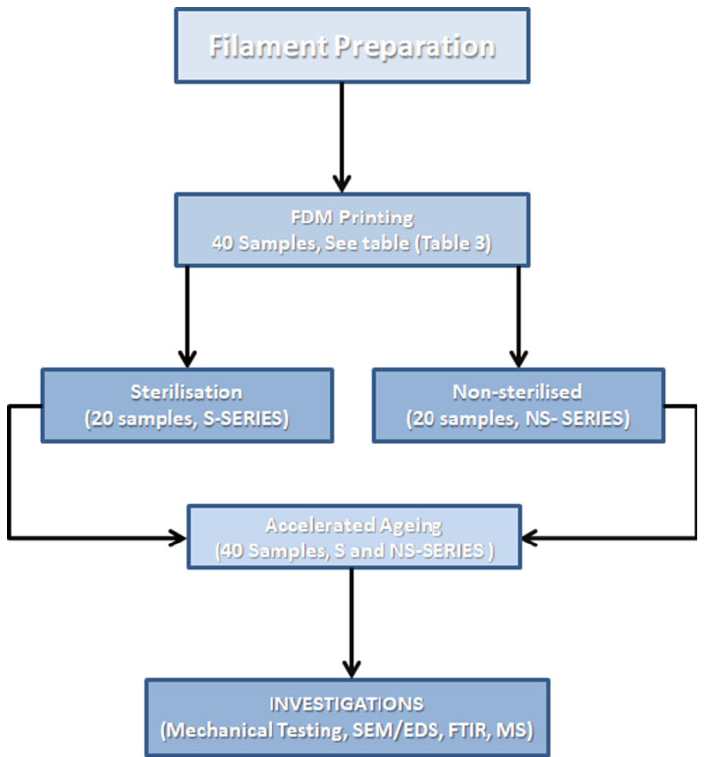
Figure 2. Process flow chart.